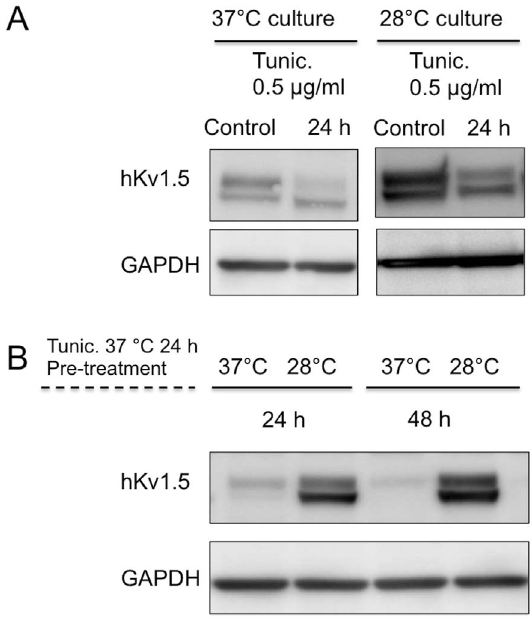
Figure 7. The process of N-glycosylation of hKv1.5 is more effective at 28 6 C than at 37 6 C. (A) Western blot analysis of the hKv1.5 expression cultured at 37 u C or 28 u C for 24 h in the presence of tunicamycin (Tunic), a N-glycosylation inhibitor. (B) The CHO-hKv1.5s cells were pre-treated with tunicamycin for 24 h at 37 u C, and then washed to stop its blocking action. The cells were continuously cultured at 37 u C or 28 u C for the indicated times.